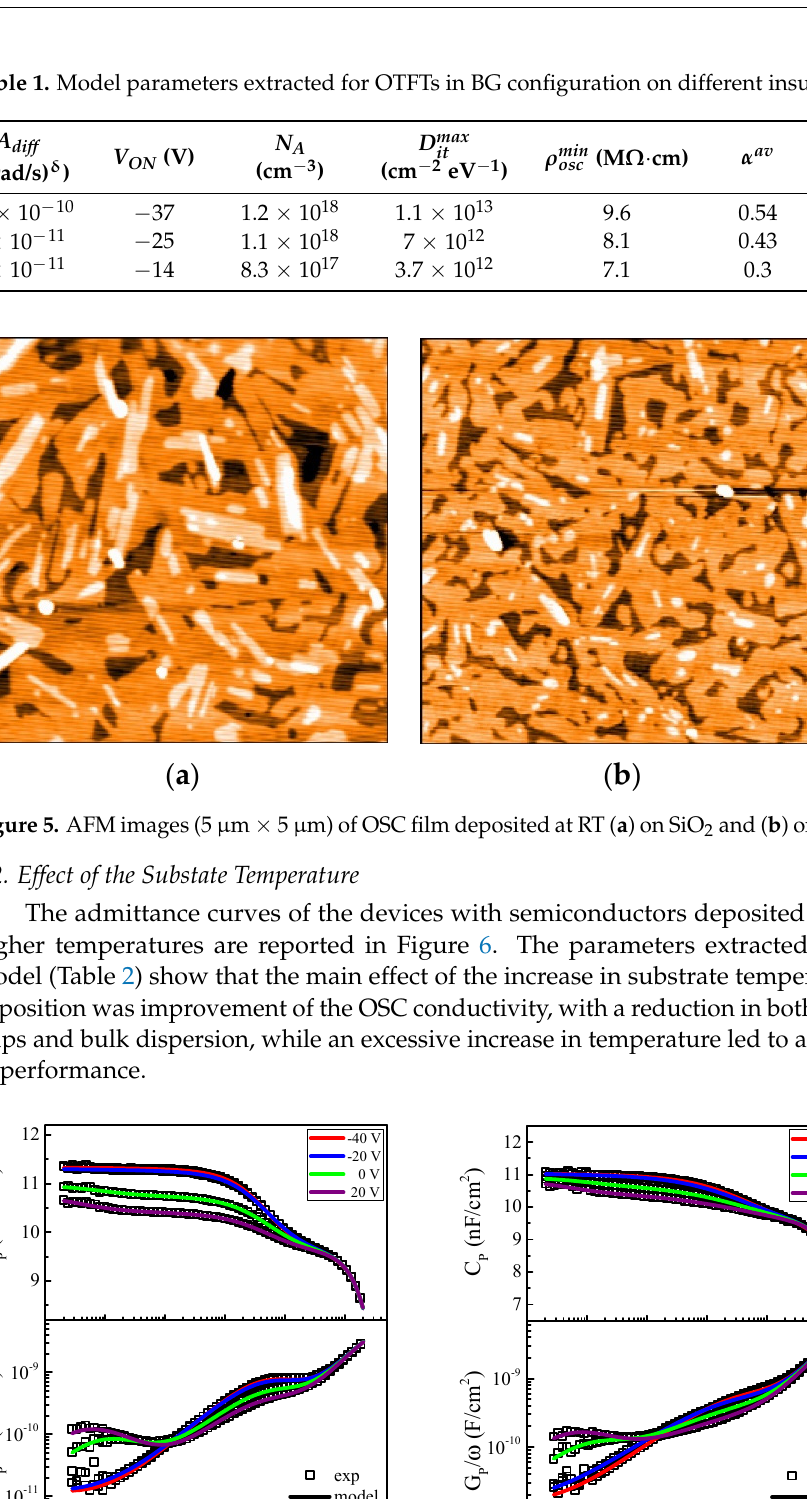
Figure 6. Admittance curves of MIS devices with semiconductor deposited on SiO 2 /HMDS at ( a ) 90 °C and ( b ) 120 °C. Model curves (solid lines) are superimposed on the experimental data (squared symbols).